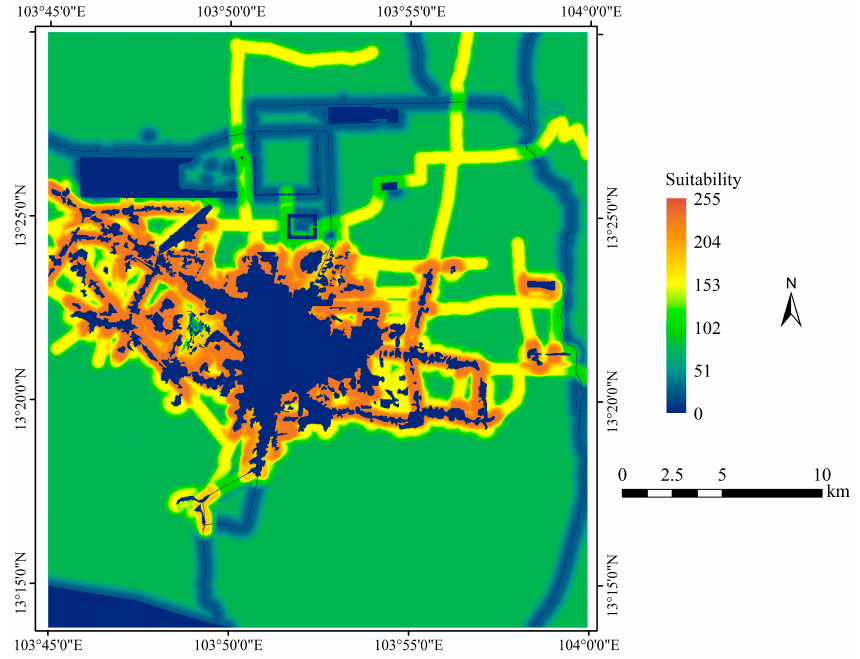
Figure 5. Suitability